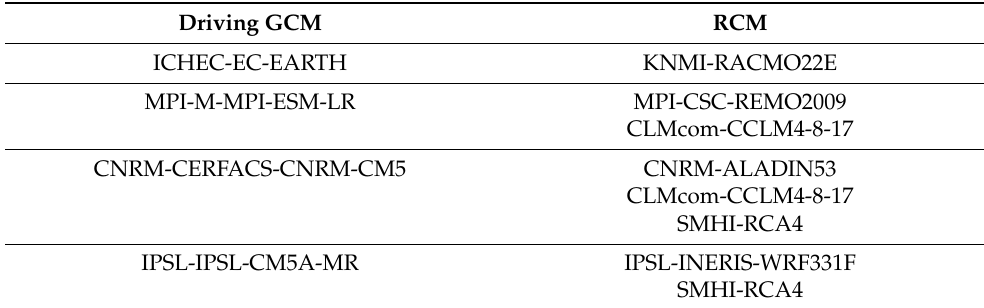
Table 1. Global and regional climate models used by the